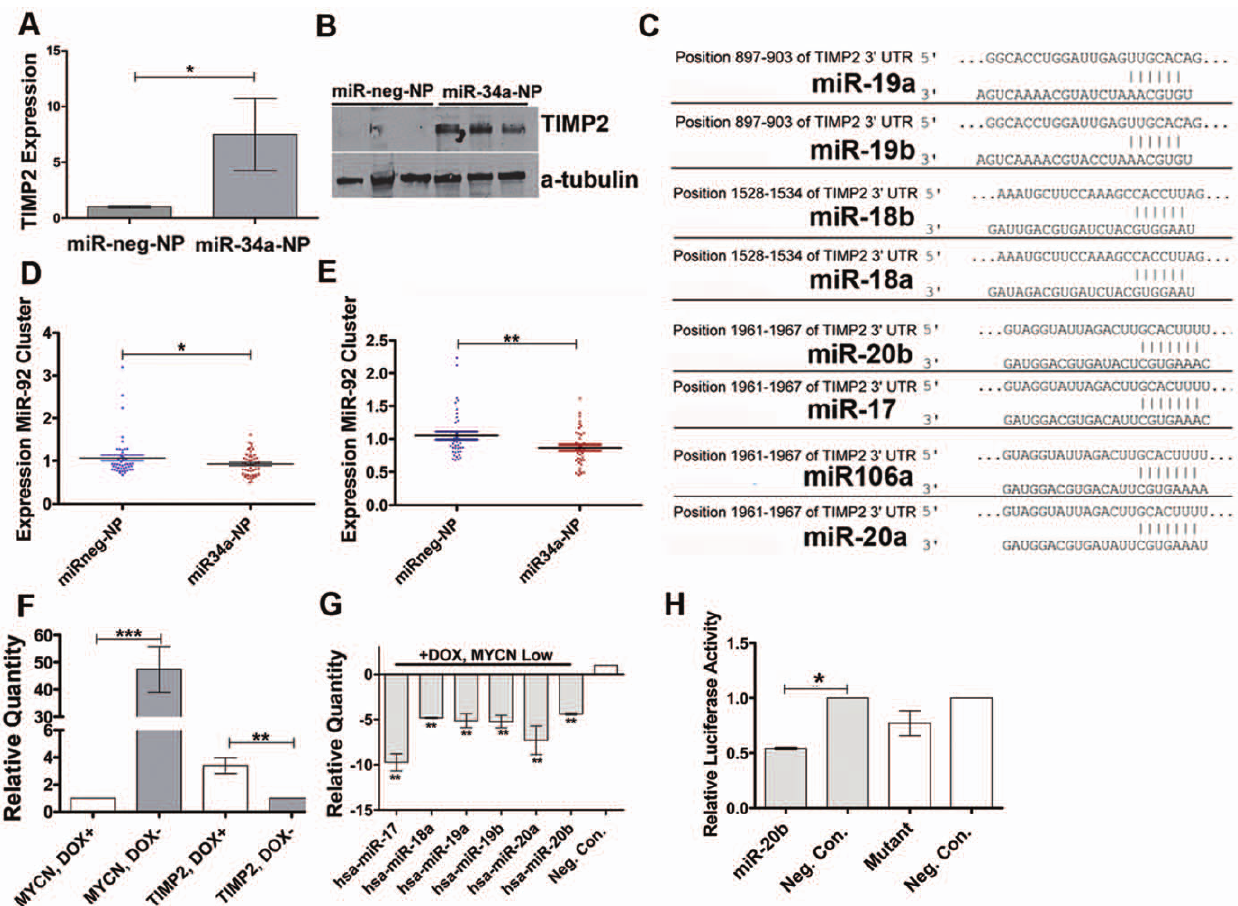
Figure 6. Molecular events involved with miR-34a anti-angiogenic effects. (A) qPCR and (B) western blot analyses of TIMP2 mRNA (n=4 tumors) and protein levels (n=3 tumors) from NB1691 tumors treated with anti-GD-miR-neg-NP or anti-GD20miR34a-NP. (C) Computationally predicted target sites on the 3 9 UTR of TIMP2 for miR-92 polycistronic cluster members from chromosome 13 and X. qPCR analysis of miR-92 cluster members from chromosome 13 (D) and chromosome X (E) in tumors treated with anti-GD-miR-neg-NP (n=8) or anti-GD20miR34a-NP (n=8). (F) qPCR analysis of MYCN and TIMP2 expression in SHEP TET21 cells possessing a repressible MYCN transgene. Expression levels of these genes in cells treated (DOX + ) and untreated (DOX-) with doxycycline are displayed. (G) Expression levels of miR-92 cluster members in SHEP TET21 following treatment with doxycycline (MYCN low expression state)(n=5 biological replicate experiments). (H) Luciferase assays following co-transfection of NB1691 cells with a reporter construct containing a wild type TIMP2 3 9 UTR region and either miR-20b mimics or a negative control oligonucleotide (n=2). Luciferase activity following co-transfection of the same cell line with a plasmid having a mutated binding site for miR-20b and either miR-20b mimics or a negative control oligonucleotide is also